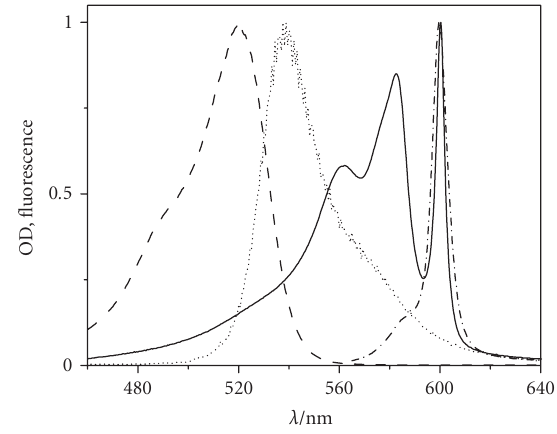
Figure 5: Normalized absorption and fluorescence spectra of C8O3 monomers (absorption—dashed line; fluorescence—dotted line), and aggregates (absorption—solid line; fluorescence—dash-dotted line).